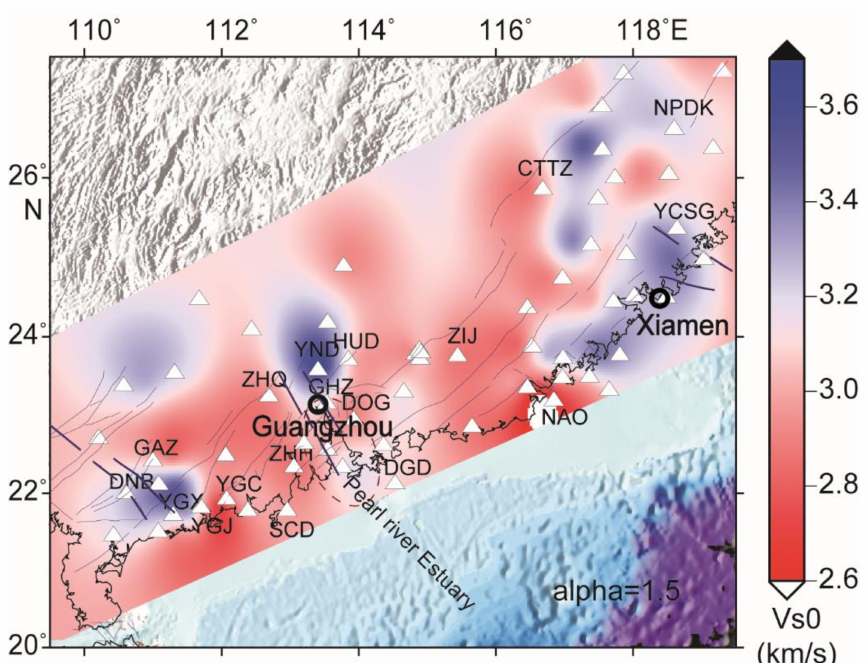
Figure 5. SWVs after the interpolation of each station (alpha = 1.5, H ∼ = 5 km) around the study area. The white triangle represents the seismic station. The tight line represents the fault, and the thick line represents the fault extending in the NW-SE